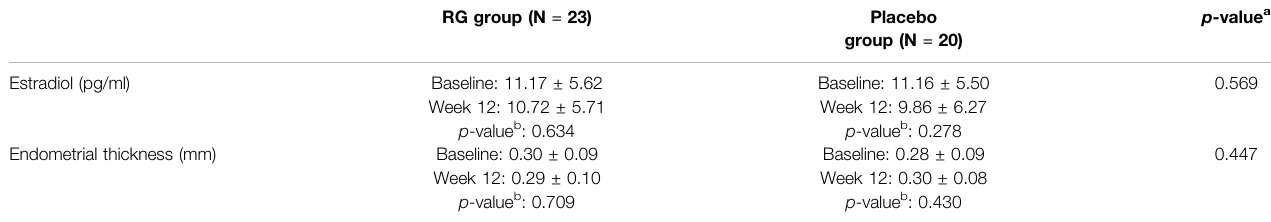
TABLE 7 | Serum estradiol levels and endometrial thickness at baseline and week 12.